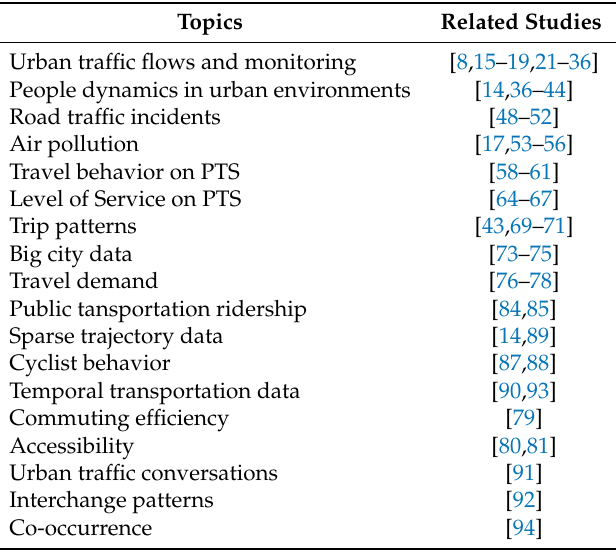
Table 1. Topics of surveyed studies and their representatives.